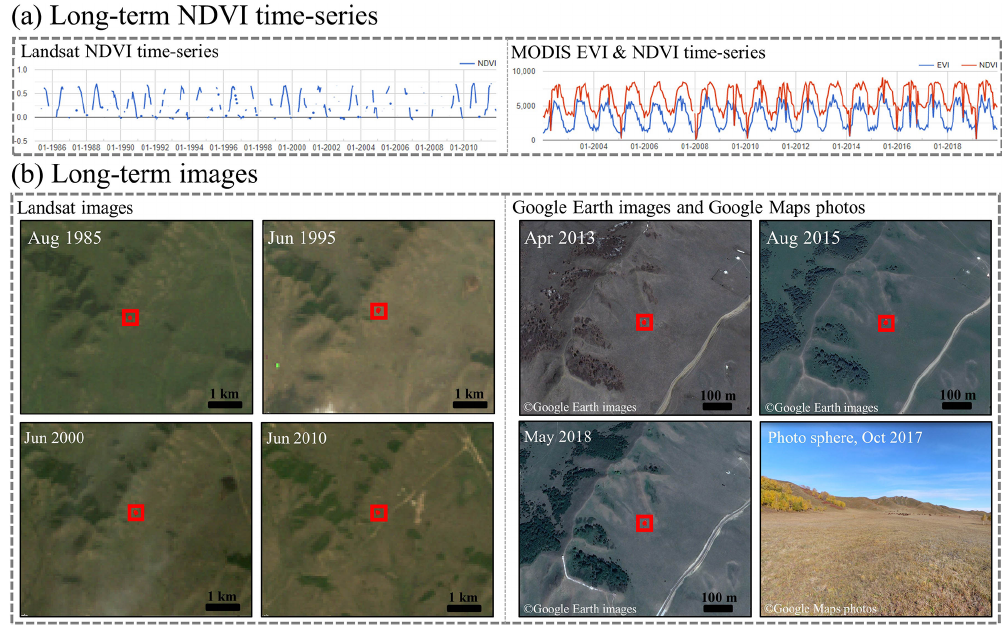
Figure 3. An example of auxiliary data used to interpret the training samples, including Landsat NDVI time series, MODIS NDVI and EVI time series, Landsat images, Google Earth images, and Google Maps photos. The red dot represents a sample site located at 42.541067 ◦ N, 117.146569 ◦